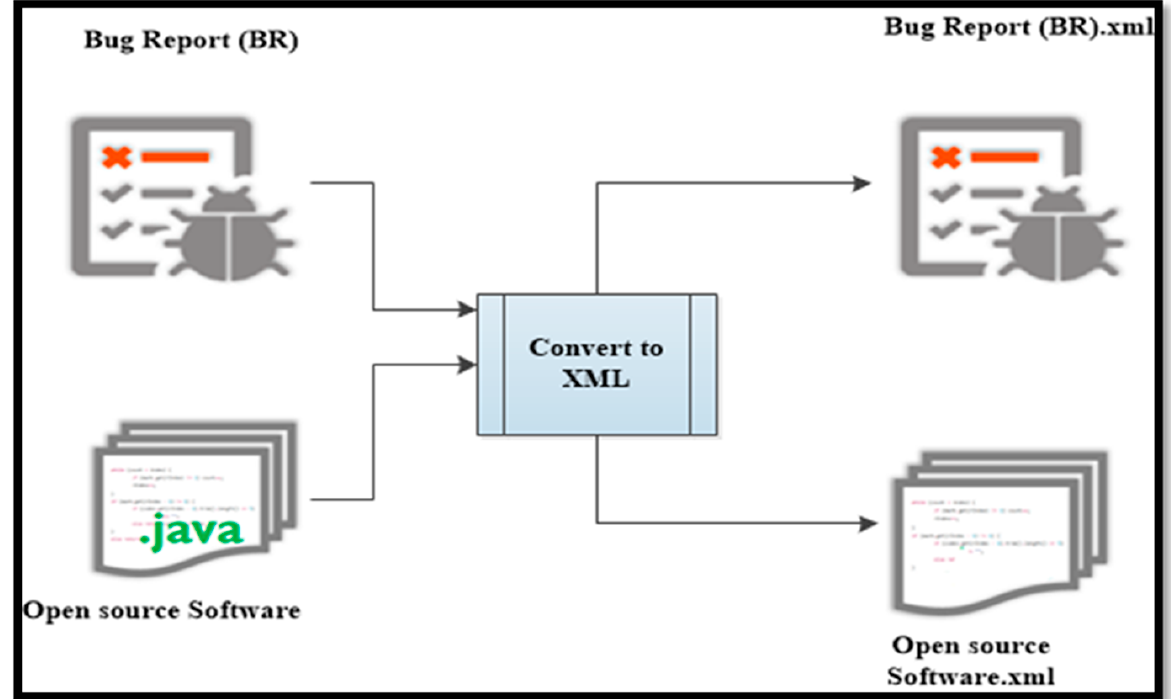
Figure 3. The process of conversion.